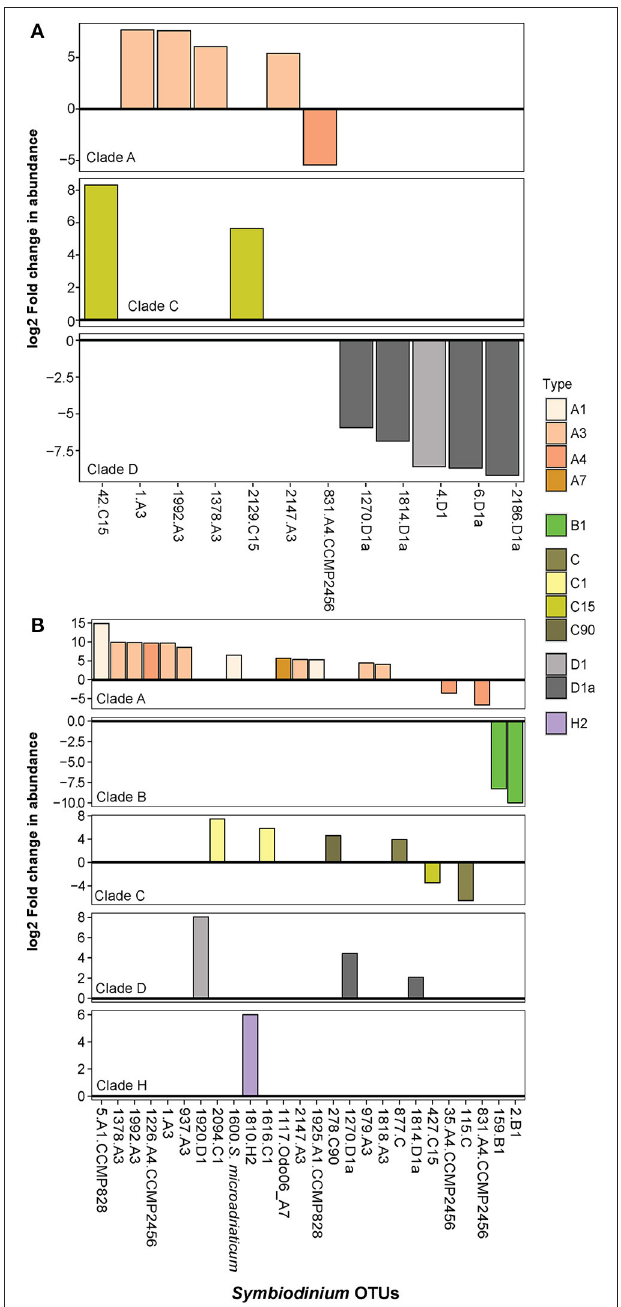
FIGURE 6 | Significant log2 fold changes in normalized abundances of Symbiodinium OTUs in juveniles exposed to: (A) inshore vs. offshore sediments, and (B) central vs. northern sector sediments. OTUs above the y = 0 line (in bold and black) are Symbiodinium OTUs that were found in significantly greater abundances in: (A) offshore than in inshore sediments, and (B) in northern sector sediments than central sediments.